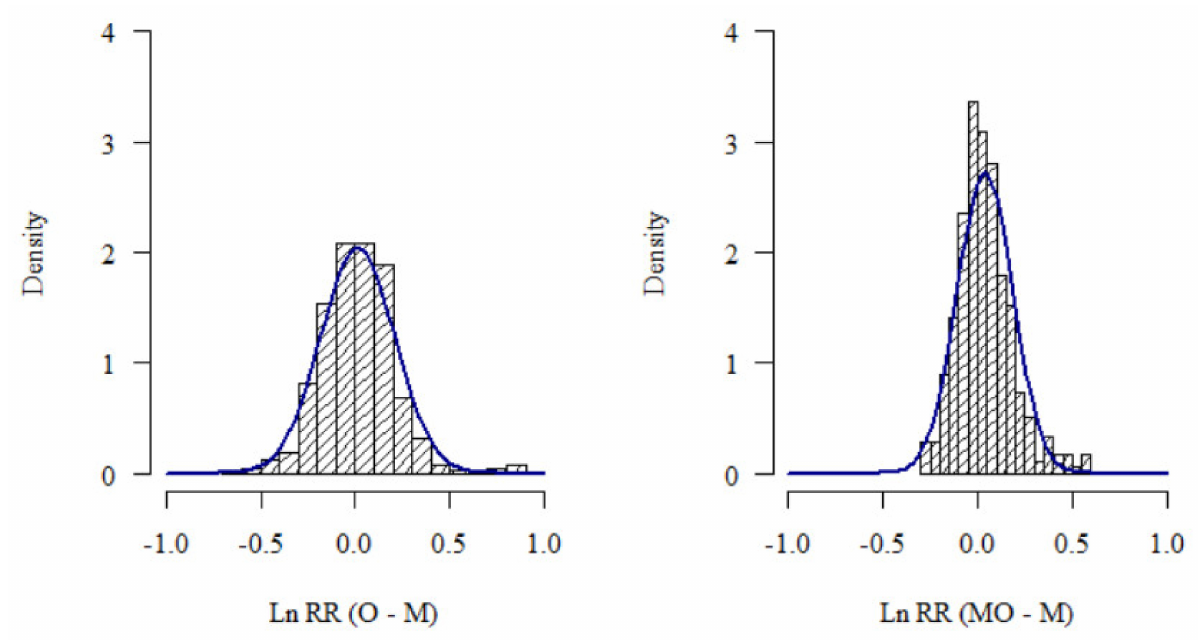
Figure 2. Normal distribution of the effect of O or MO compared to M on crop productivity (ef- fect